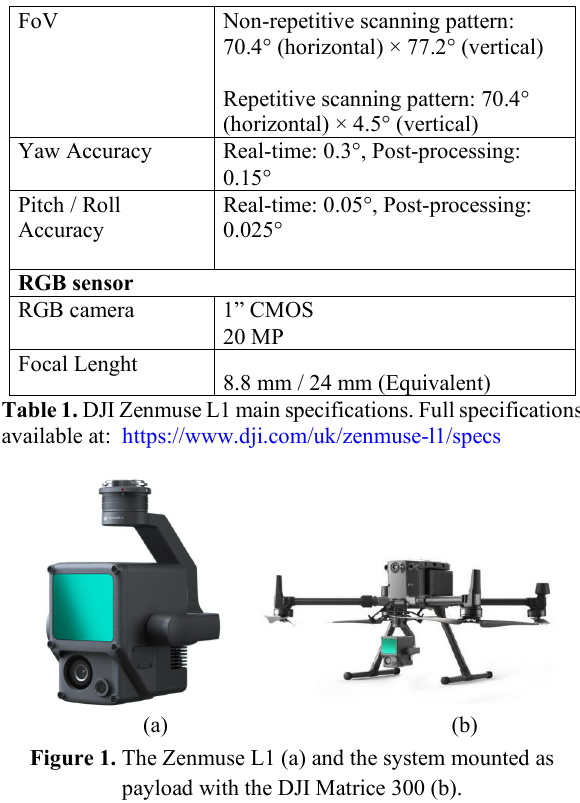
Table 2. Faro Focus 3D X330 main